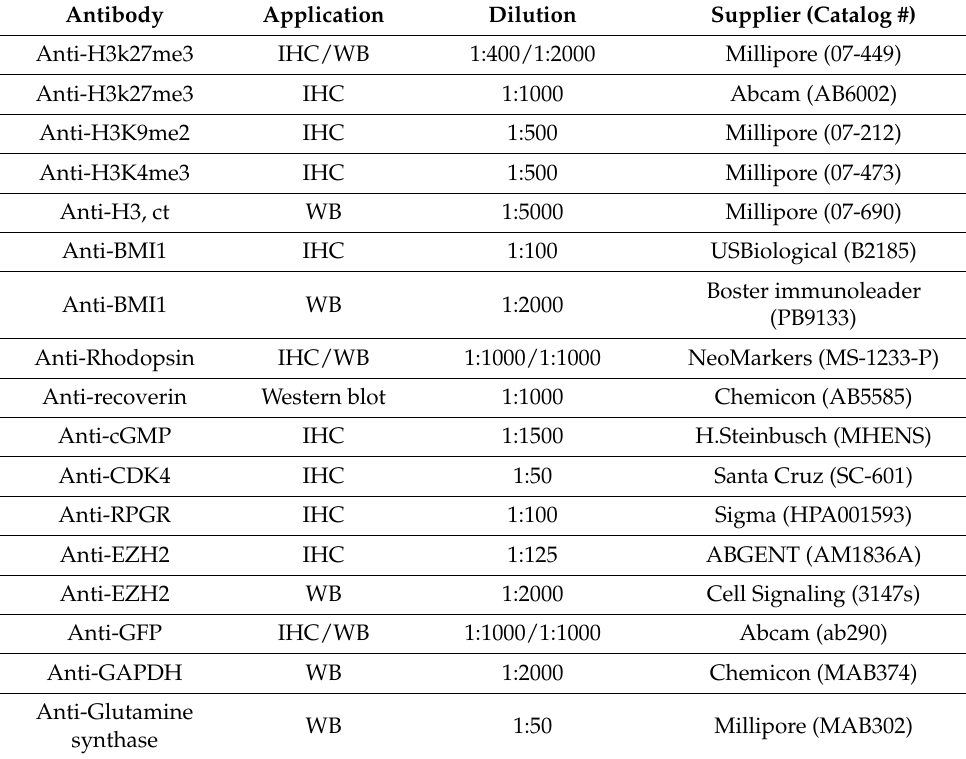
Table 2. List of antibodies used in the